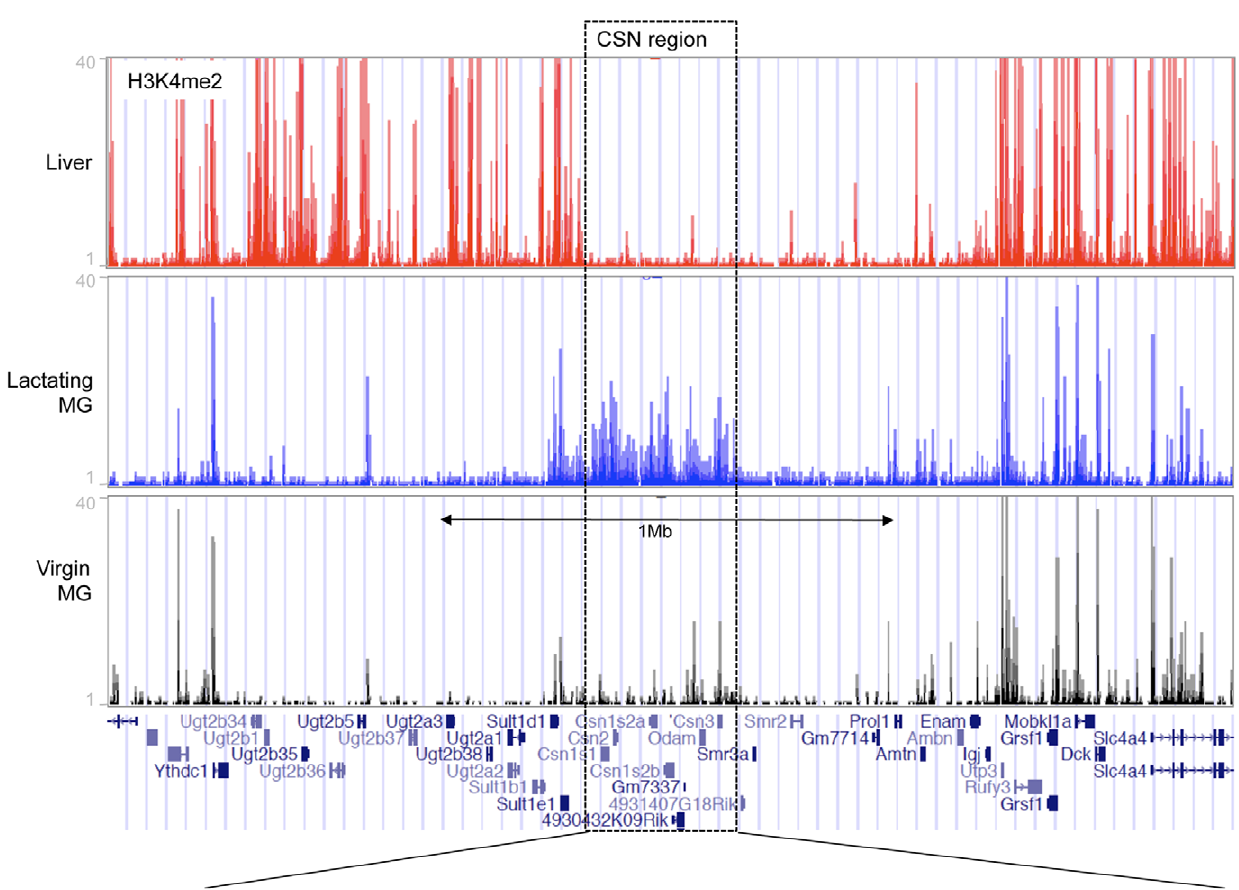
Figure 1. Summary of ChIP-seq for H3K4me2 at the casein gene cluster region and flanking regions. ChIP-seq reads aligned to mouse gene assembly mm9 in the UCSC Genome Browser for H3K4me2 enrichment in liver tissue (red), lactating mammary gland (blue) and mammary epithelial cells (MEC) isolated from 12 week old virgin animals in diestrus (black). The bottom panel displays the locations of annotated genes.